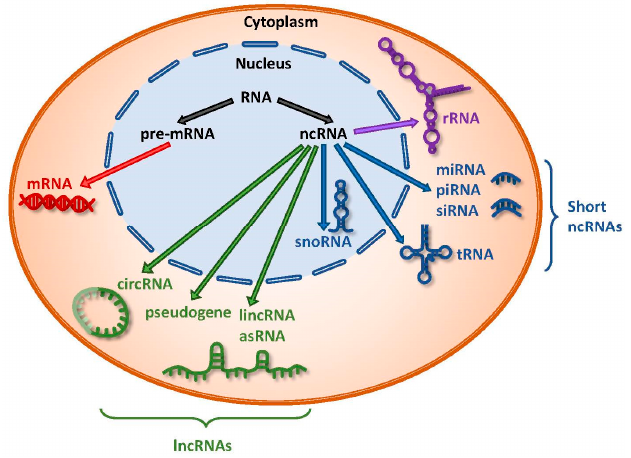
Figure 1. Coding and noncoding classes of RNA. Precursor messenger RNA (pre-mRNA) gives rise to protein-coding messenger RNA (mRNA). Noncoding RNAs (ncRNAs) include ribosomal RNA (rRNA) and other species that can be categorized into short and long ncRNAs. Short ncRNAs consist of microRNA (miRNA), Piwi-interacting RNA (piRNA), small interfering RNA (siRNA), transfer RNA (tRNA), and small nucleolar RNA (snoRNA). Long ncRNAs (lncRNAs) include long intergenic ncRNA (lincRNA), antisense RNA (asRNA), pseudogenes, and circular RNA (circRNA). LncRNAs are defined as transcripts greater than 200 nucleotides, transcribed by RNA polymerase II, but not translated into proteins [15]. They can also be subjected to common post- transcriptional modifications, including 5 ′ -capping, 3 ′ -polyadenylation, and splicing [15].